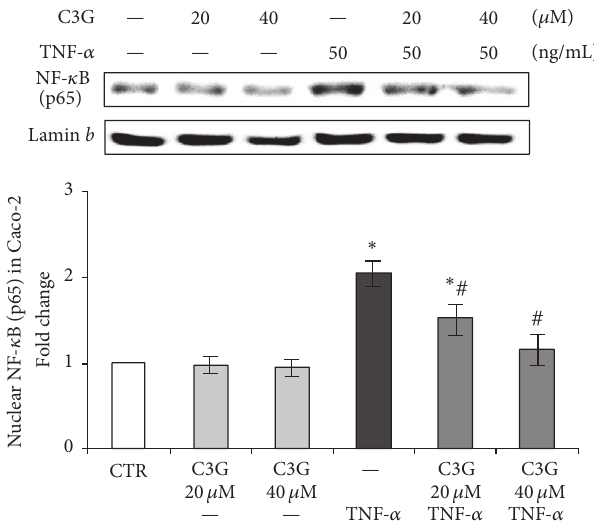
—CTR — Figure 2: Nuclear NF- 𝜅 B (p65) in Caco-2 cells. The Caco-2 mon- olayer was pretreated for 24 hours with C3G (20 or 40 𝜇 M) and subsequently exposed to 50 ng/mL TNF- 𝛼 for 1 hour. Cultures treated with the vehicle alone (0.1% DMSO) were used as controls (CTR). Caco-2 cell nuclear lysates were analyzed by western blot, and nuclear localization of the p65 protein was evaluated. Results are reported as fold change against control and expressed as mean ± SD of three independent experiments. NF- 𝜅 B (p65) intensity values were normalized to the corresponding Lamin 𝑏 value. ∗ 𝑝 < 0.05 versus CTR; # 𝑝 < 0.05 versus TNF- 𝛼